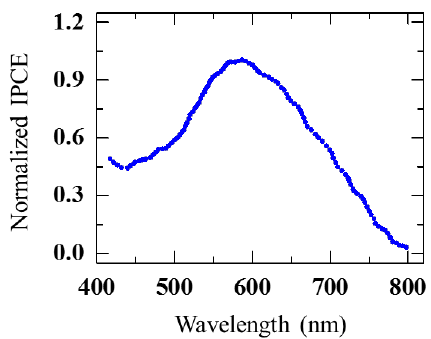
Figure 14. Measured IPCE (normalized) vs. incident wavelength (nm). Adapted from [86] with permission from the PCCP Owner Societies, 2017.